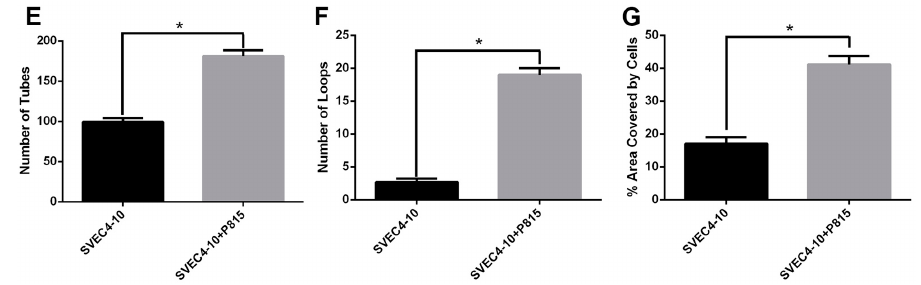
Figure 1. Mast cells induce tube and loop formation. ( A , C ) SVEC4-10 cells; ( B , D ) SVEC4-10 cells co-cultured with P815 mast cells. Tubes (arrows) and loops (L) were increased in the co-cultures after 5 h. ( A , B ) Cells were stained with phalloidin conjugated to Alexa 488; the nuclei were counterstained with DAPI (4’, 6-Diamine-2’-phenylindole dihydrochloride); ( C , D ) scanning electron microscopy; ( E – G ) The graphs show the average number of tubes ( E ) and loops ( F ) and the area covered by cells ( G ) after 5 h of culture. The structures were quantified using Wimasis WimTube. Data are presented as mean ± SD from five independent experiments. * p ≤ 0.05.